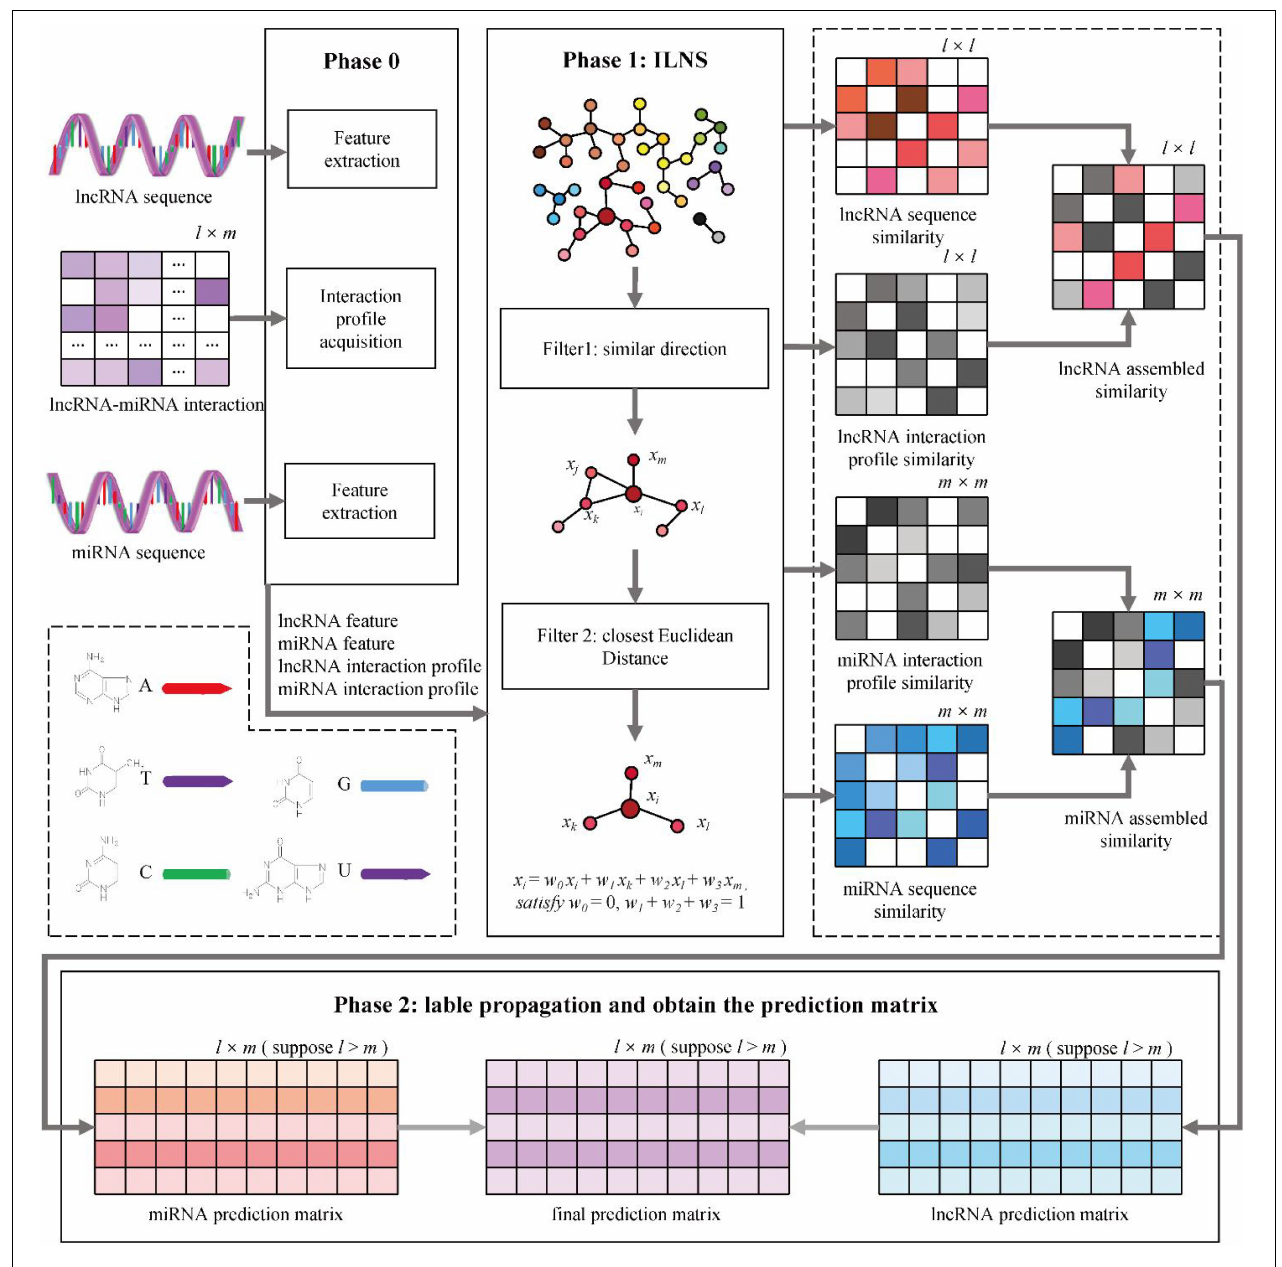
FIGURE 2 | MILNP for predictions. Phase 0: Extraction of sequence features and interaction profiles. Phase 1: Calculation of sequence similarity and interaction profile similarity to generate integrated similarity. Phase 2: Label propagation using weighted sum to obtain the final prediction